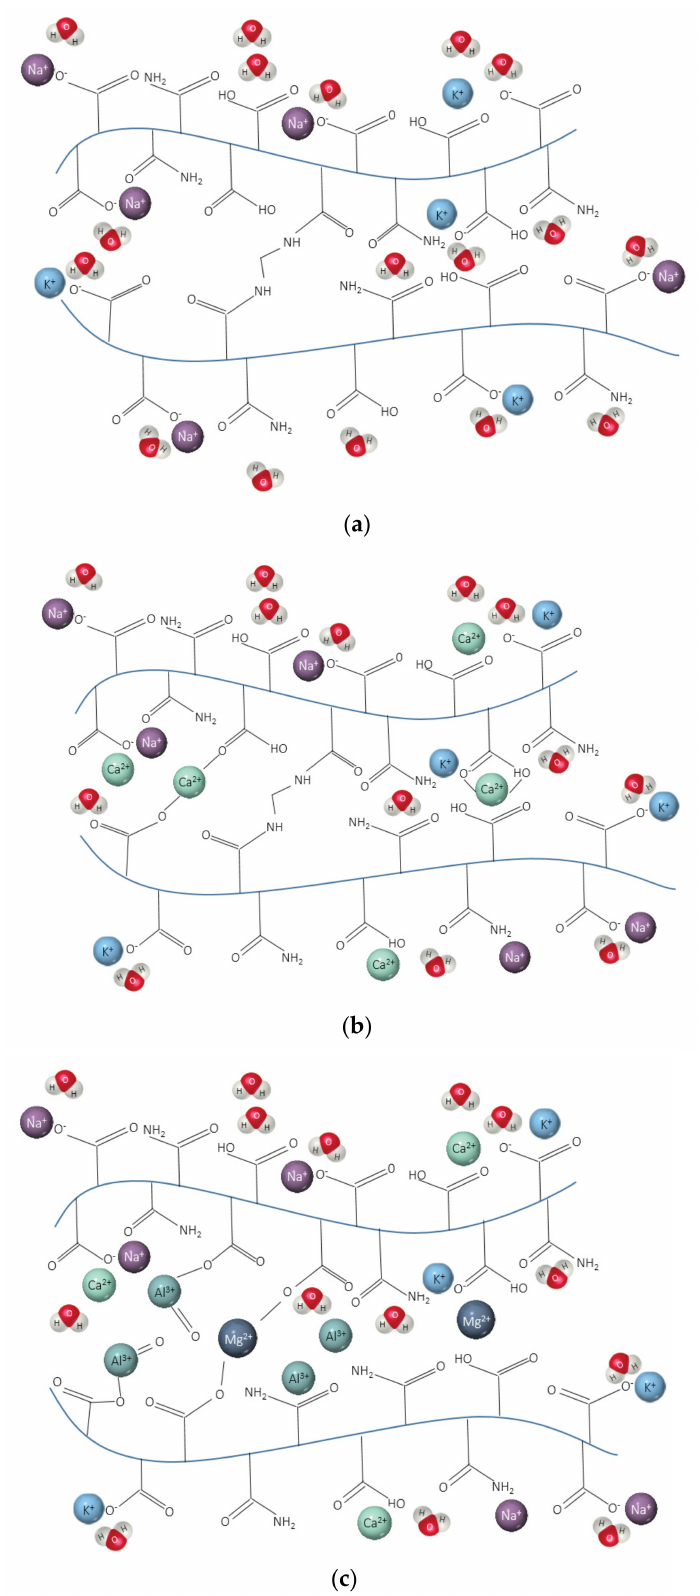
Figure 17. Schematic overview of the chemical structure of SAP in ( a ) DI water, ( b ) in CEM I (PC) solution, and ( c ) in blended cements solutions (adapted from